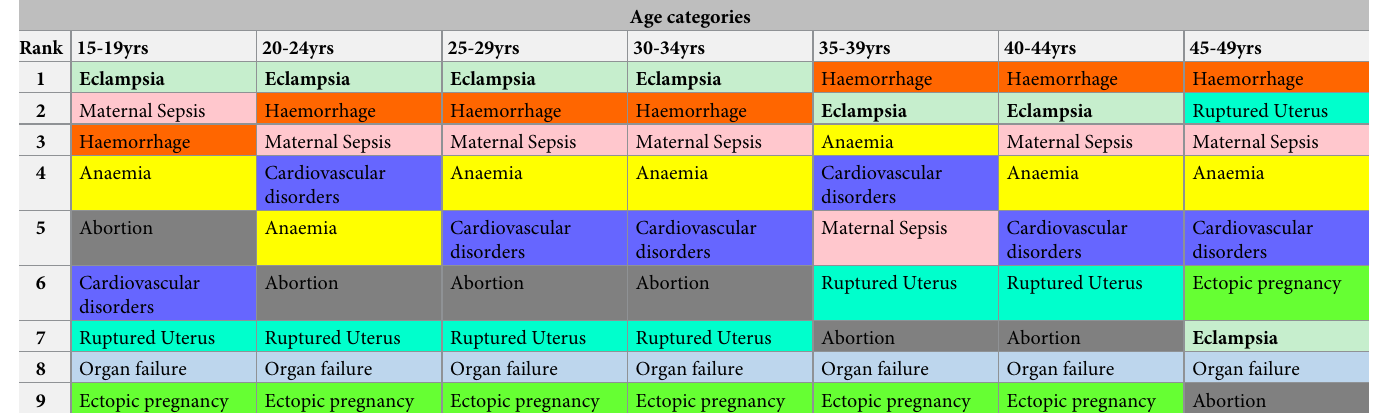
Table 4. Ranking of the causes of maternal deaths by age category.